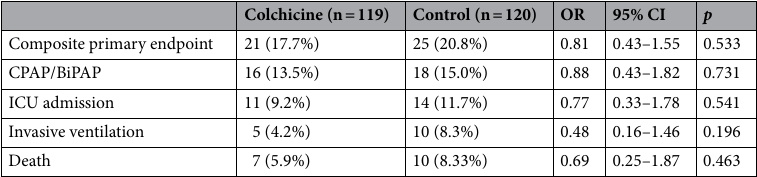
Colchicine (n = 119) Control (n = 120) OR 95% CI